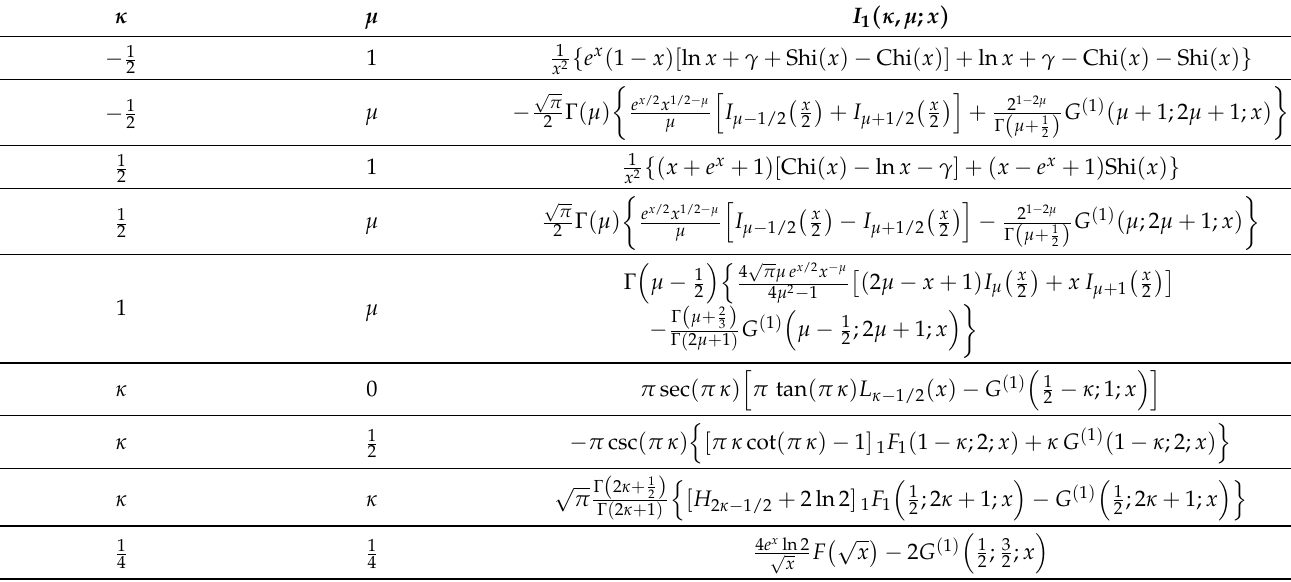
Table 5. Integral I 1 ( κ , µ ; x ) for particular values of κ and µ